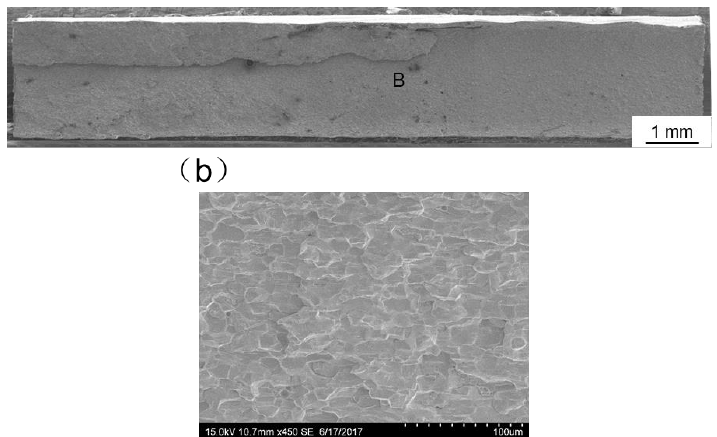
Figure 16. SEM images of tensile fracture when the offset is 0.5 mm (( a ) Overall morphology; ( b ) Magnified images of region B in panel ( a )).